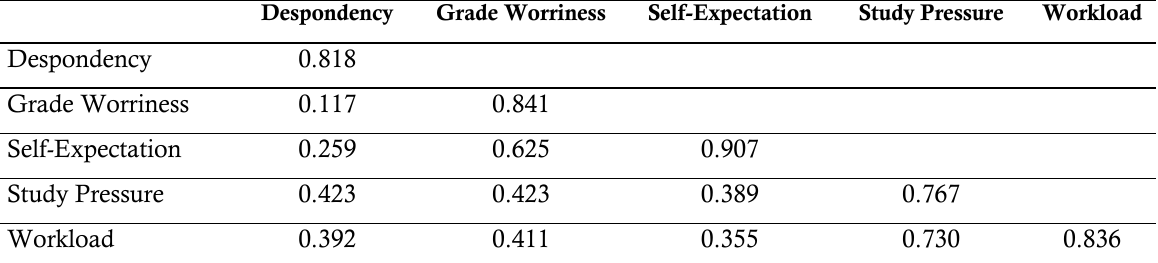
Table 3. The Fornell-Larcker